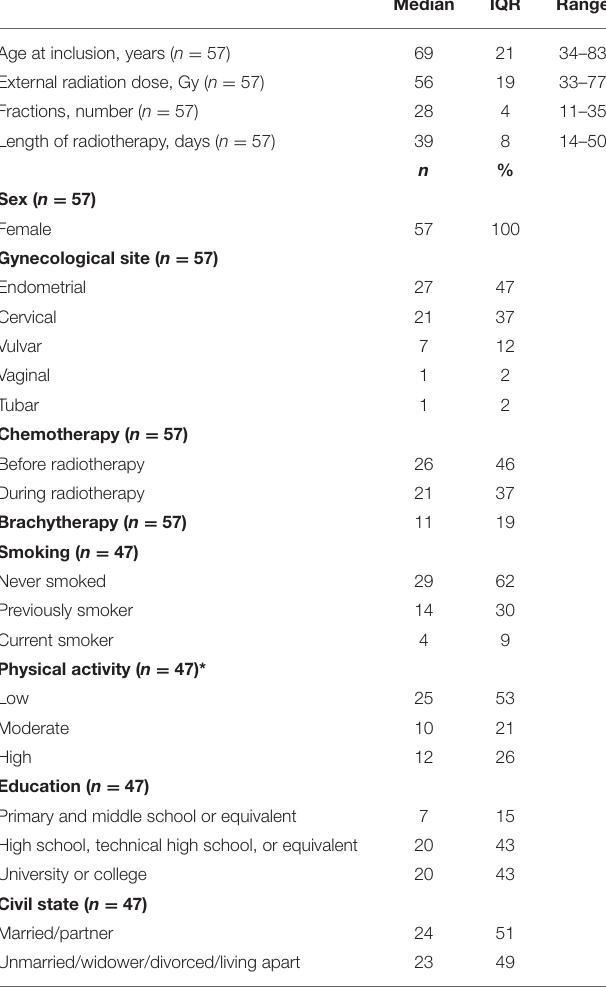
TABLE 2 | Baseline characteristics of the participants in the preparatory study.